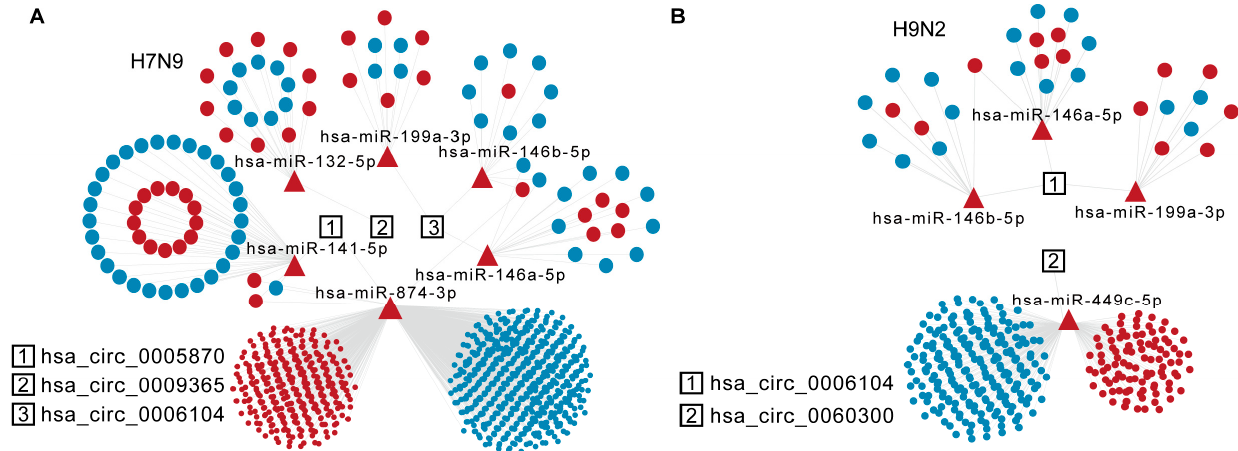
Figure 5. Specific analysis of significantly up-regulated trans-targeted genes of circRNAs. ( A ) The diagram displays significantly up-regulated circRNAs in the H7N9 virus 16 hpi ceRNA network. ( B ) The diagram displays significantly up-regulated circRNAs in the H9N2 virus 16 hpi ceRNA network. The